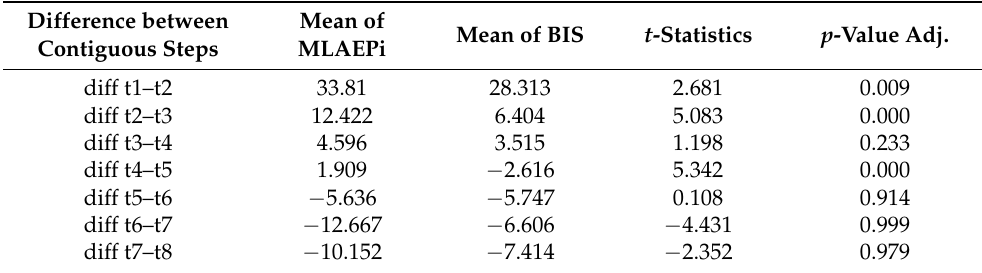
Table 5. Two sample t-tests comparing the slopes of the Middle latency auditory evoked